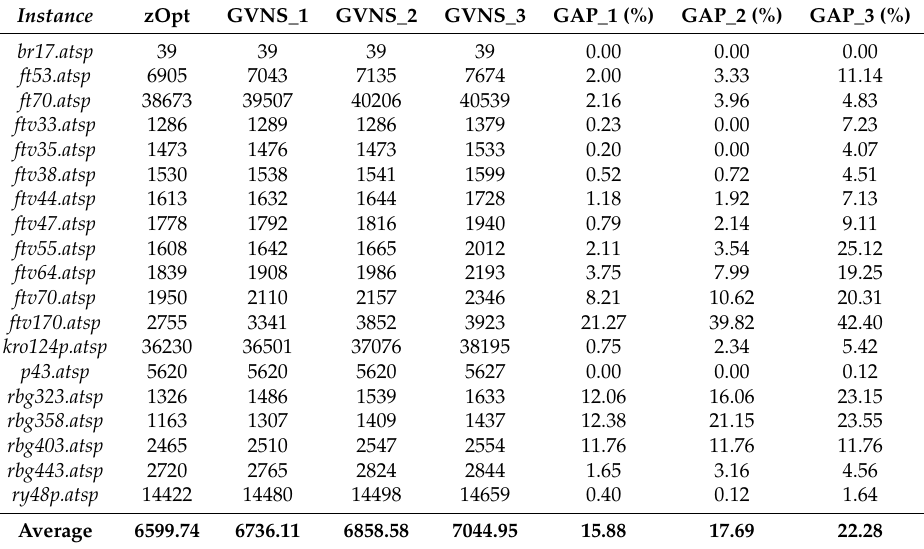
Table 2. The results depicted here were obtained using the Best Improvement search strategy and an execution time limit of 1 min [14].